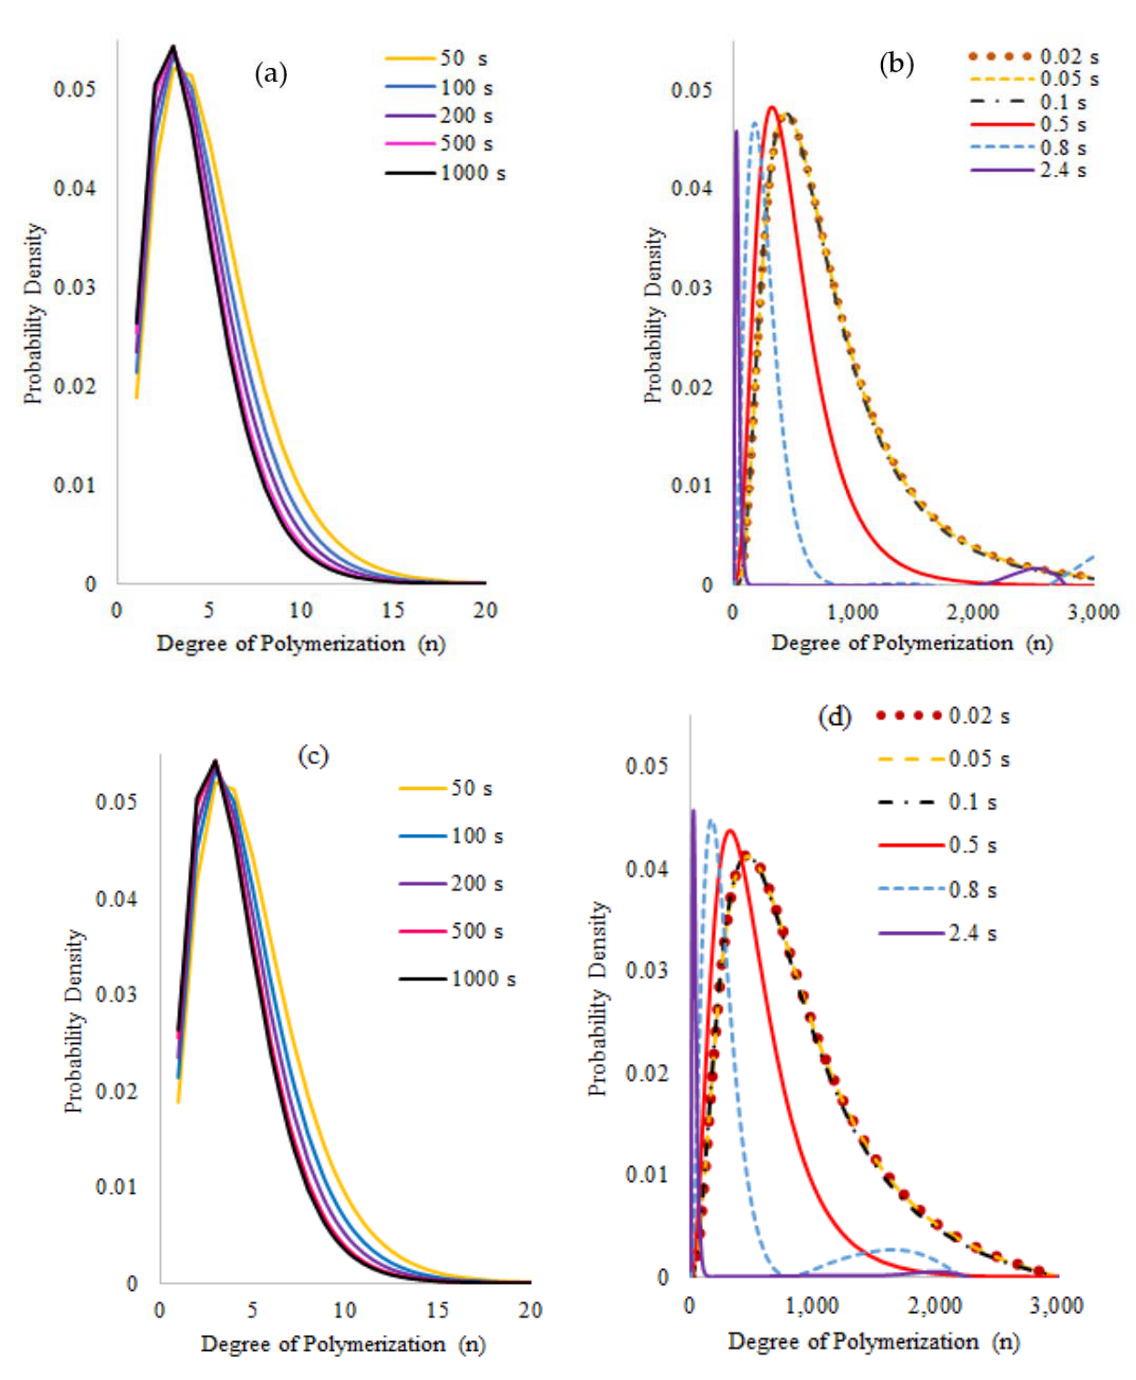
Figure 10. Molecular Weight Distribution of dead ( a , b ) and living ( c , d ) chains in the simulation of the pyrolysis of FRP-PS. Model predictions at 390 °C and reaction formulation as in Table 2.